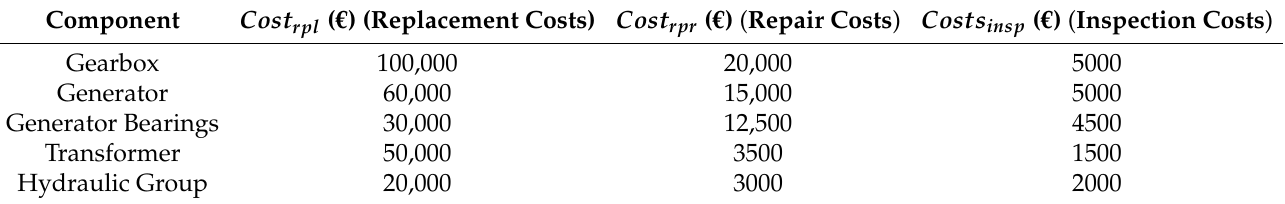
Table 2. Summary of costs assumed for the EDP evaluation